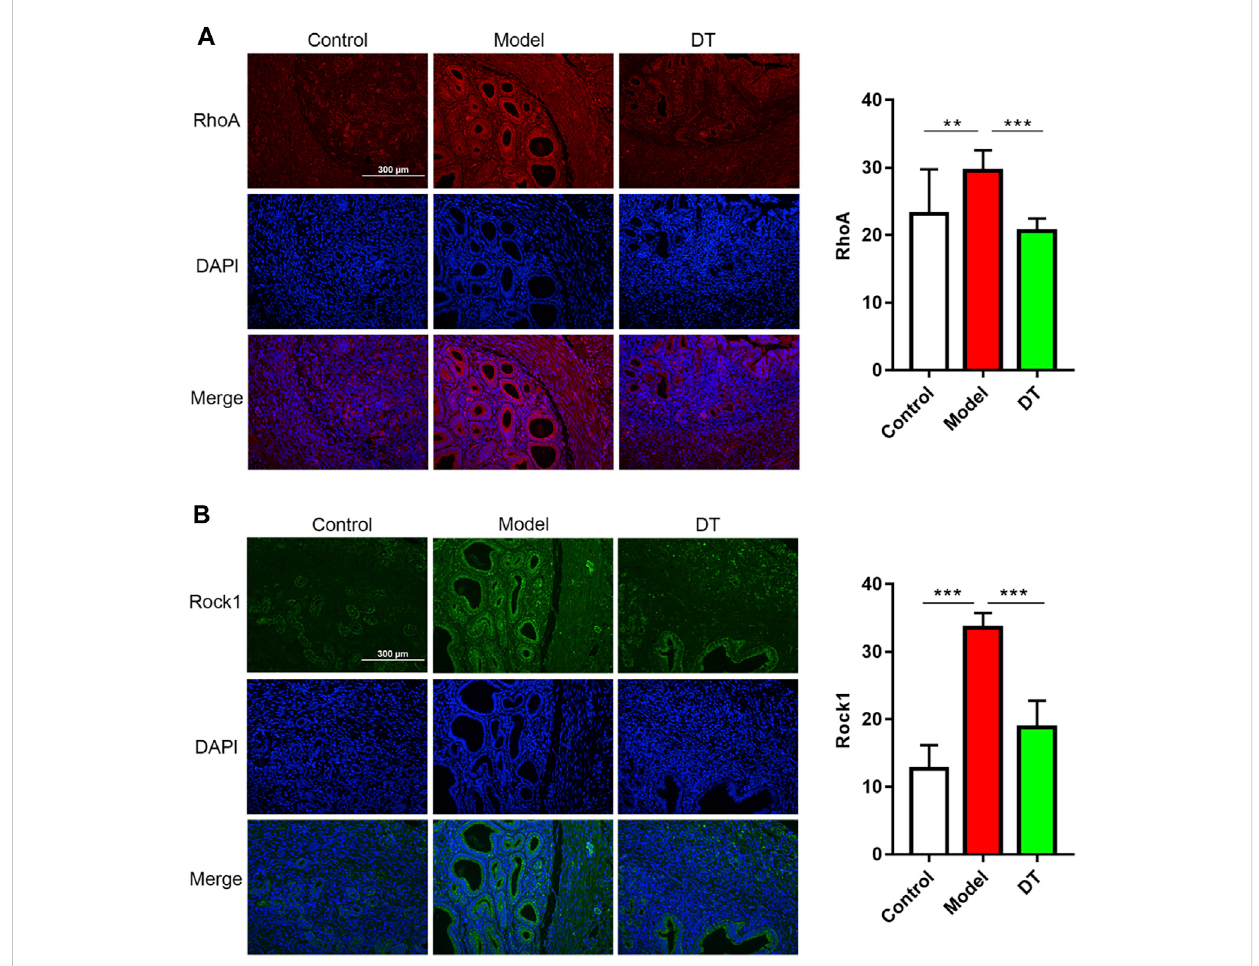
FIGURE 9 Expression of Rho GTPases in mouse uterine tissues. Immuno fl uorescence assay of RhoA (A) , red and Rock1 (B) , green and quantitative analysis of RhoA and Rock1. Data were expressed as means ± SD, **p < 0.01, ***p < 0.001 versus the model